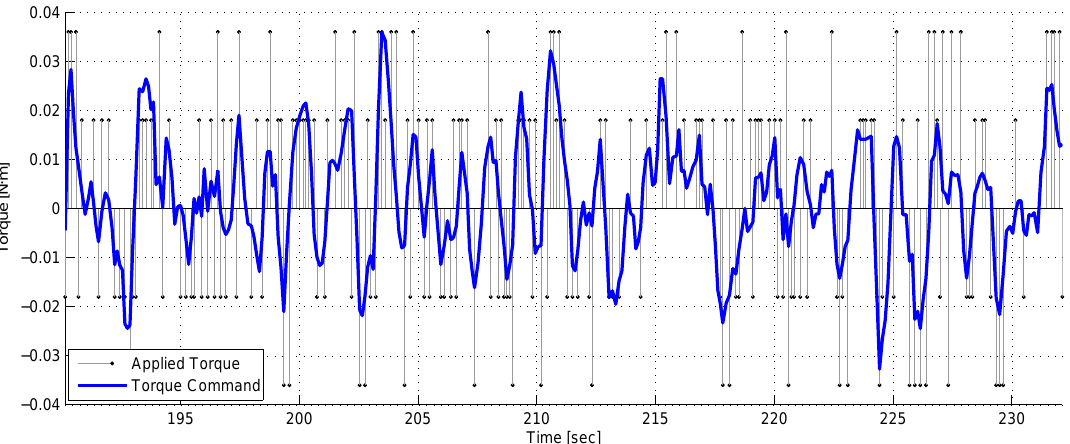
Figure 22. A comparison between the continuous control torque signal, the discrete applied torque and the PD